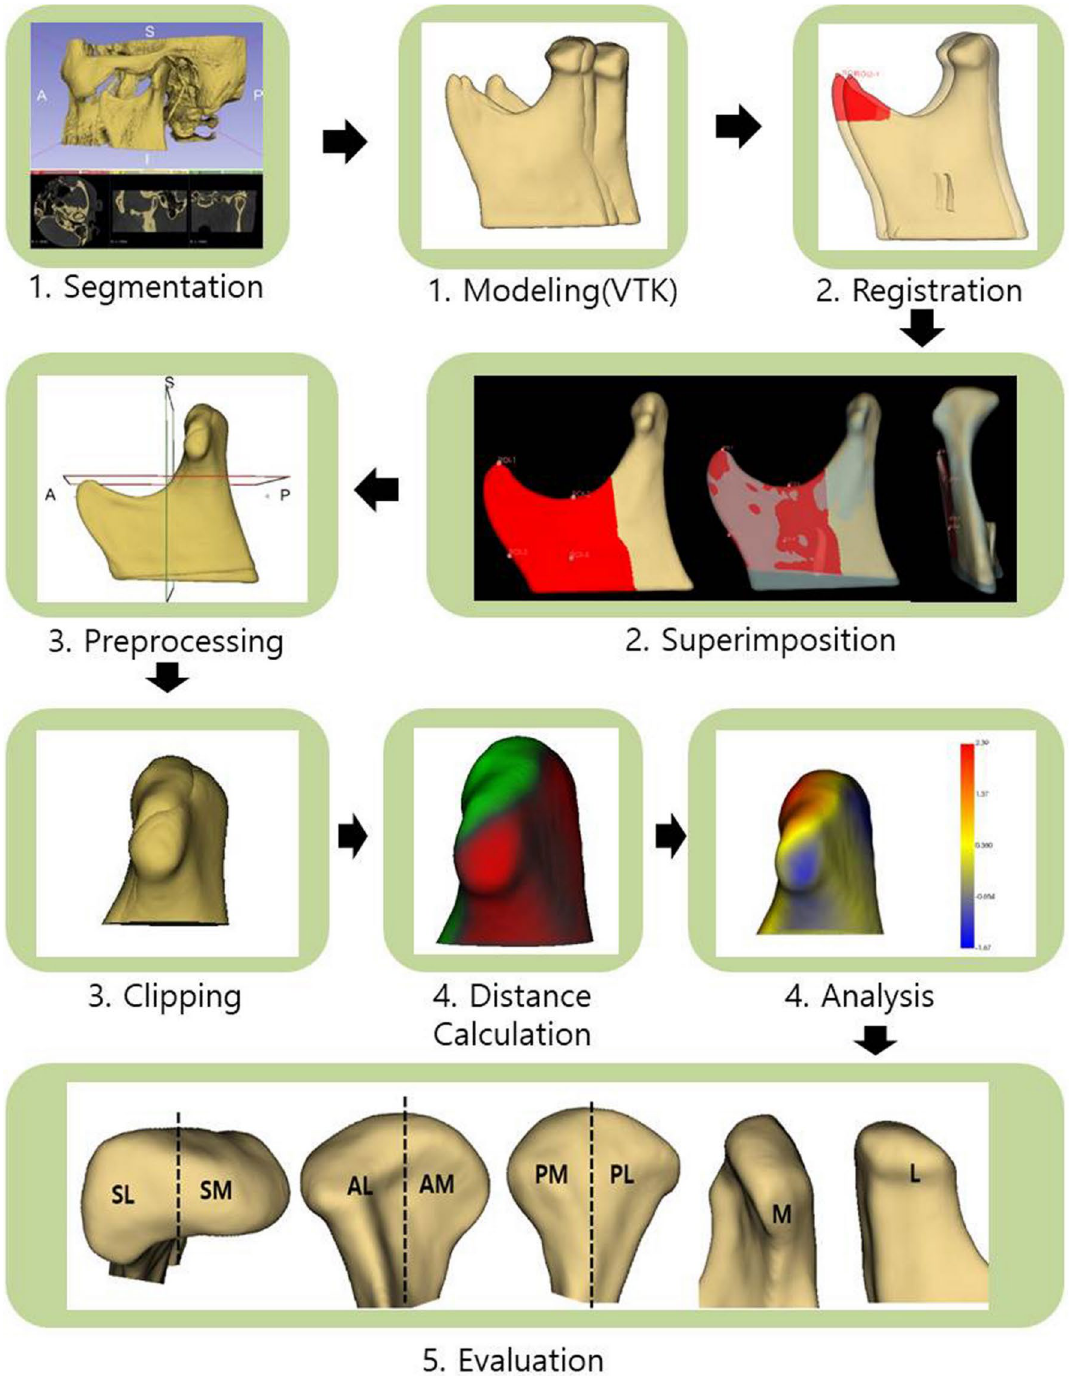
Figure 5. Technical route of the study. 1. Constructing the 3-dimensional mandibular segmentations. 2. Performing regional registration and superimposition based on the coronoid process, sigmoid notch and mandibular body 3. Generating the condylar surface model 4. Measuring the distance and color; vector map generation 5. Evaluating resorption and apposition after area specification, 3D slicer (v. 4.11.0, Slicer, http:// www. slicer.